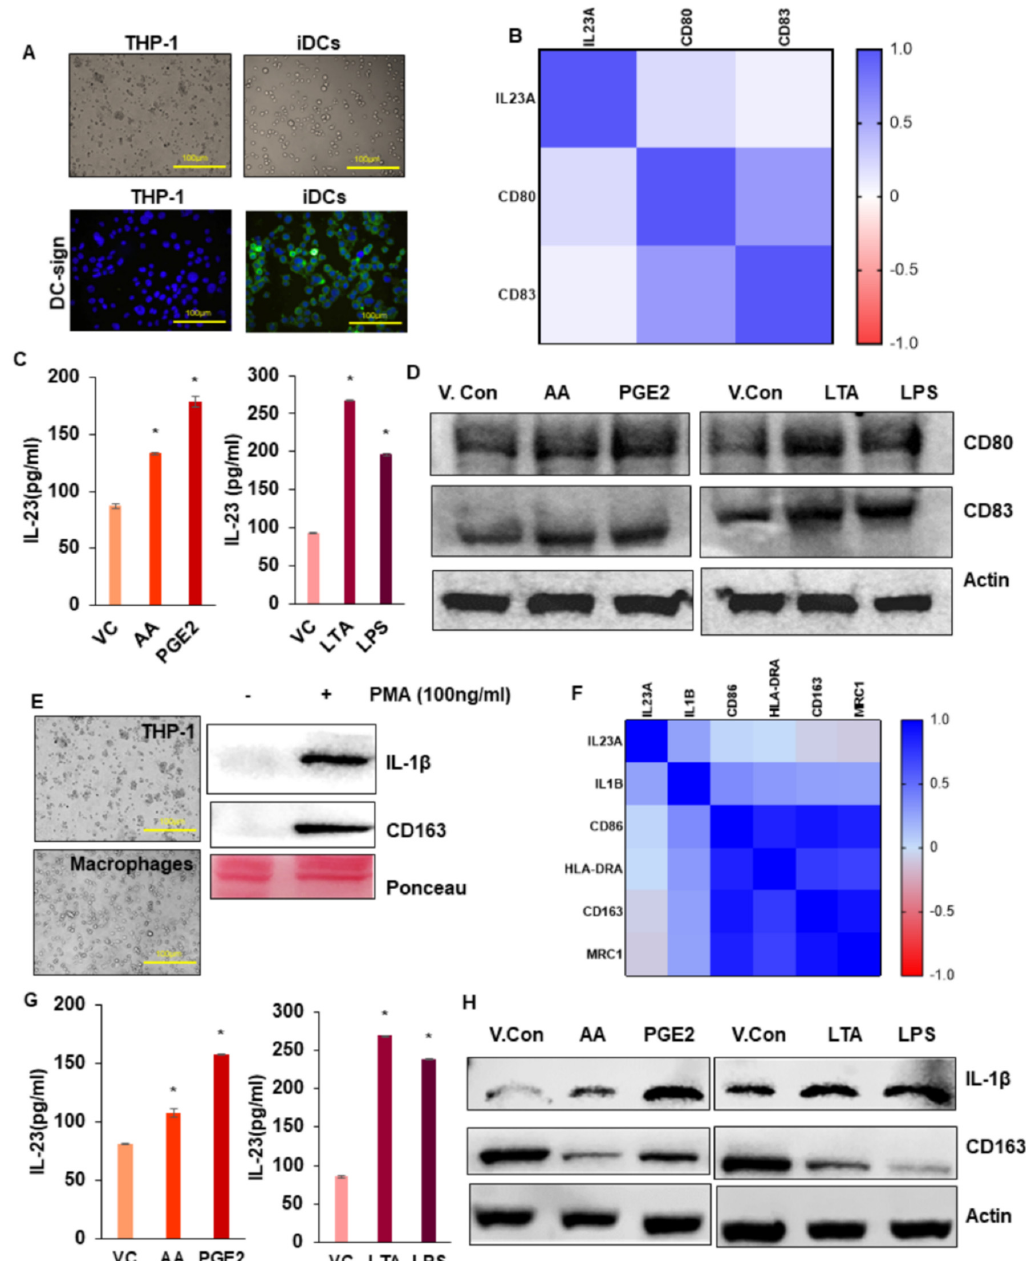
Figure 3. Effect of obesity-associated factors and bacterial toxins on IL-23 production in dendritic cells and macrophages. ( A ) Morphology (Magnification 10 × ) and immunofluorescence staining (Magnification 60 × ) of DC-sign expression in THP-1 monocytes, and immature dendritic cells. ( B ) Analysis of correlation between IL-23A with pro-tumorigenic DC marker gene expressions using the TCGA-COAD RNA-seq database. ( C ) Quantification of IL-23 level in DCs upon treatment with or without AA, PGE 2 , LTA, and LPS by ELISA. ( D ) Western blotting analysis of CD80, CD83 expression in THP-1 monocyte-derived DCs upon treatment with or without AA, PGE 2 , LTA, and LPS. ( E ) Morphology of THP-1 monocytes, macrophages (Magnification 10X), and Western blotting analysis of Macrophage markers. ( F) Analysis of correlation between IL-23A with macrophage markers gene expressions using TCGA-COAD RNA-seq database. ( G ) Quantification of IL-23 level in macrophages upon treatment with or without AA, PGE 2 , LTA, and LPS by ELISA. ( H ) Western blotting analysis of IL-1 β and CD163 expression in THP-1 monocyte-derived macrophages upon treatment with or without AA, PGE 2 , LTA, and LPS. Beta-actin was used as a protein loading control. All experiments were performed a minimum of three times. Bars denote standard deviation (SD). * p < 0.05 was considered statistically